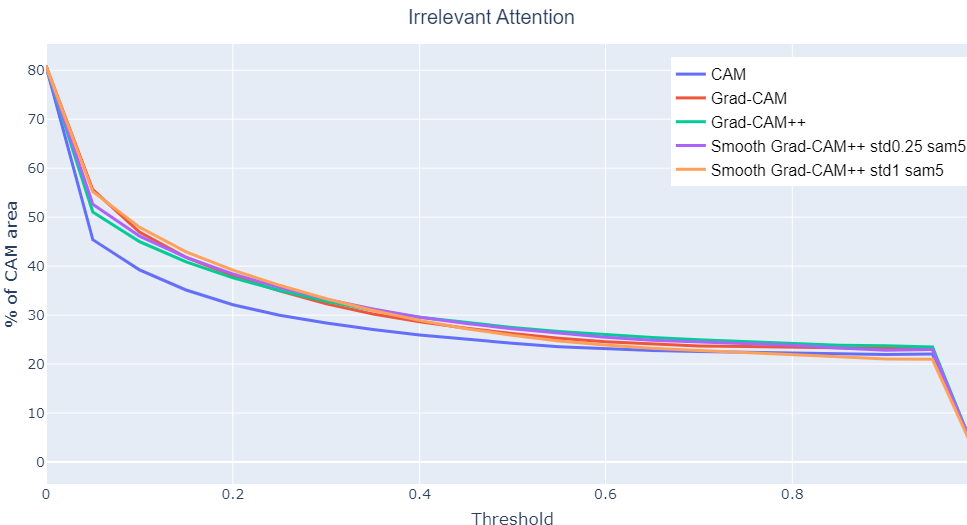
Figure 11. Irrelevant attention at varying threshold